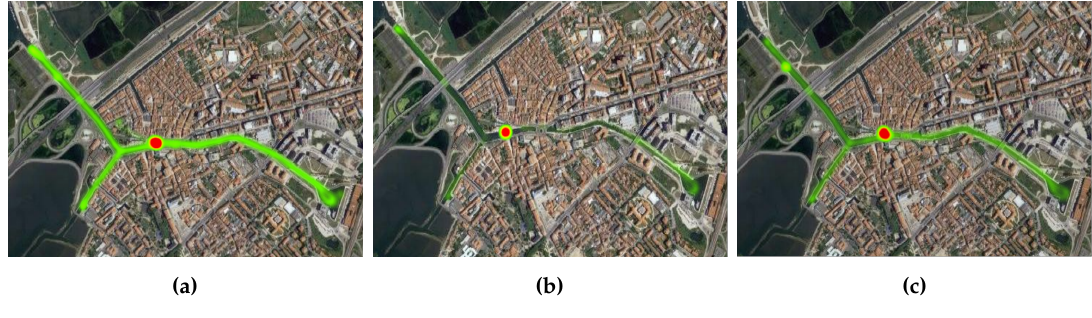
Figure 10. Moliceiros flow over day 1—Epidemic strategy evaluation ( a ) Moliceiro-101 flow;